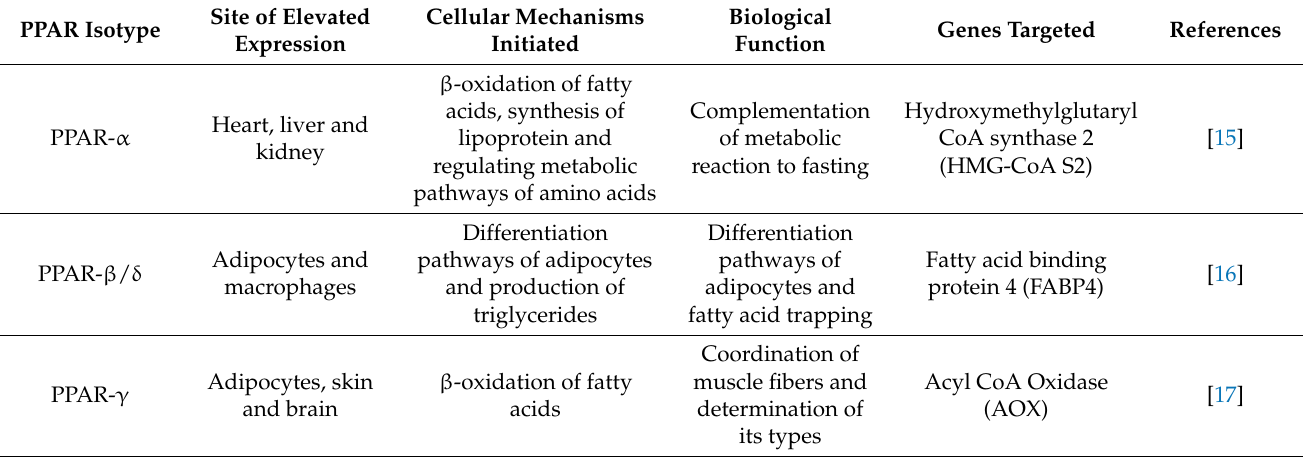
Table 1. Overview of the basic metabolic function of PPAR isotypes.